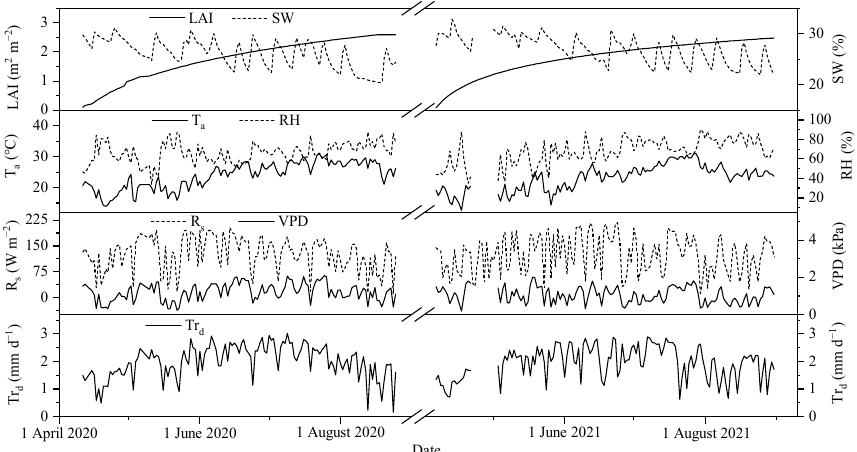
Figure 2. Dynamic changes of daily transpiration (Tr d ), solar radiation (R s ), air temperature (T a ), relative humidity (RH), vapor pressure deficit (VPD), soil water content (SW), and leaf area index (LAI).